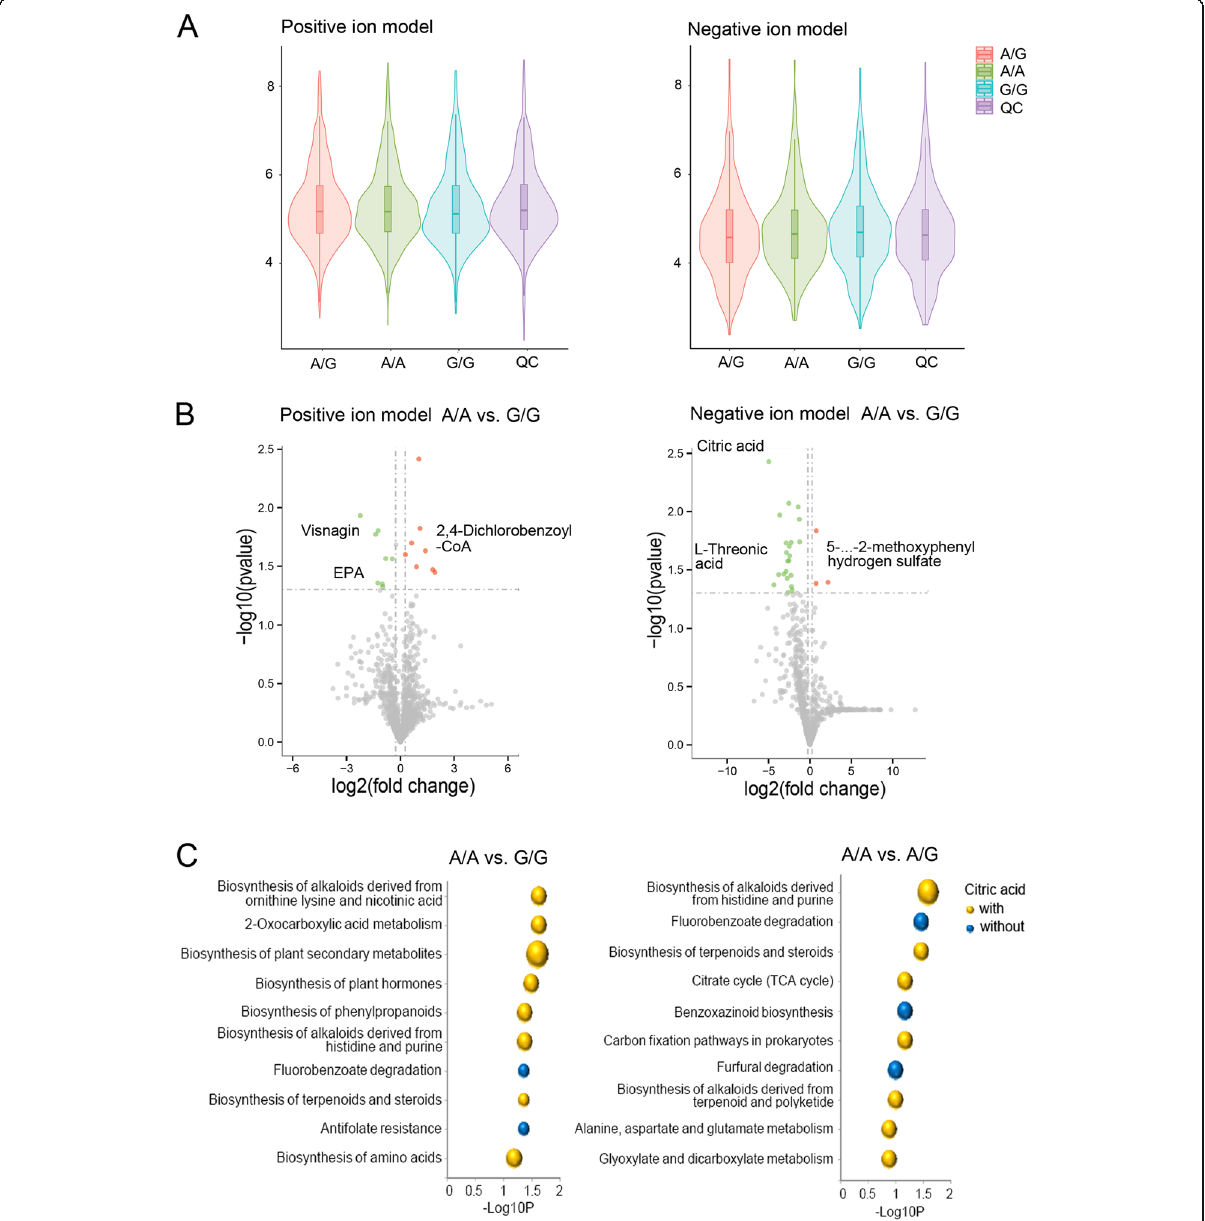
Fig. 4 Metabolic profile of ARB patients. a Distribution of metabolites in the whole family. b The significantly differential expressed metabolites (fold change > 1.2, P < 0.05). c KEGG einrichment analysis of differential expressed metabolites between ARB patients (A/A, n = 2) and their wild- type sisters (G/G, n = 3) and between ARB patients (A/A, n = 2) and the heterozygosity group (A/G, n = 2). The size of the bubble represents